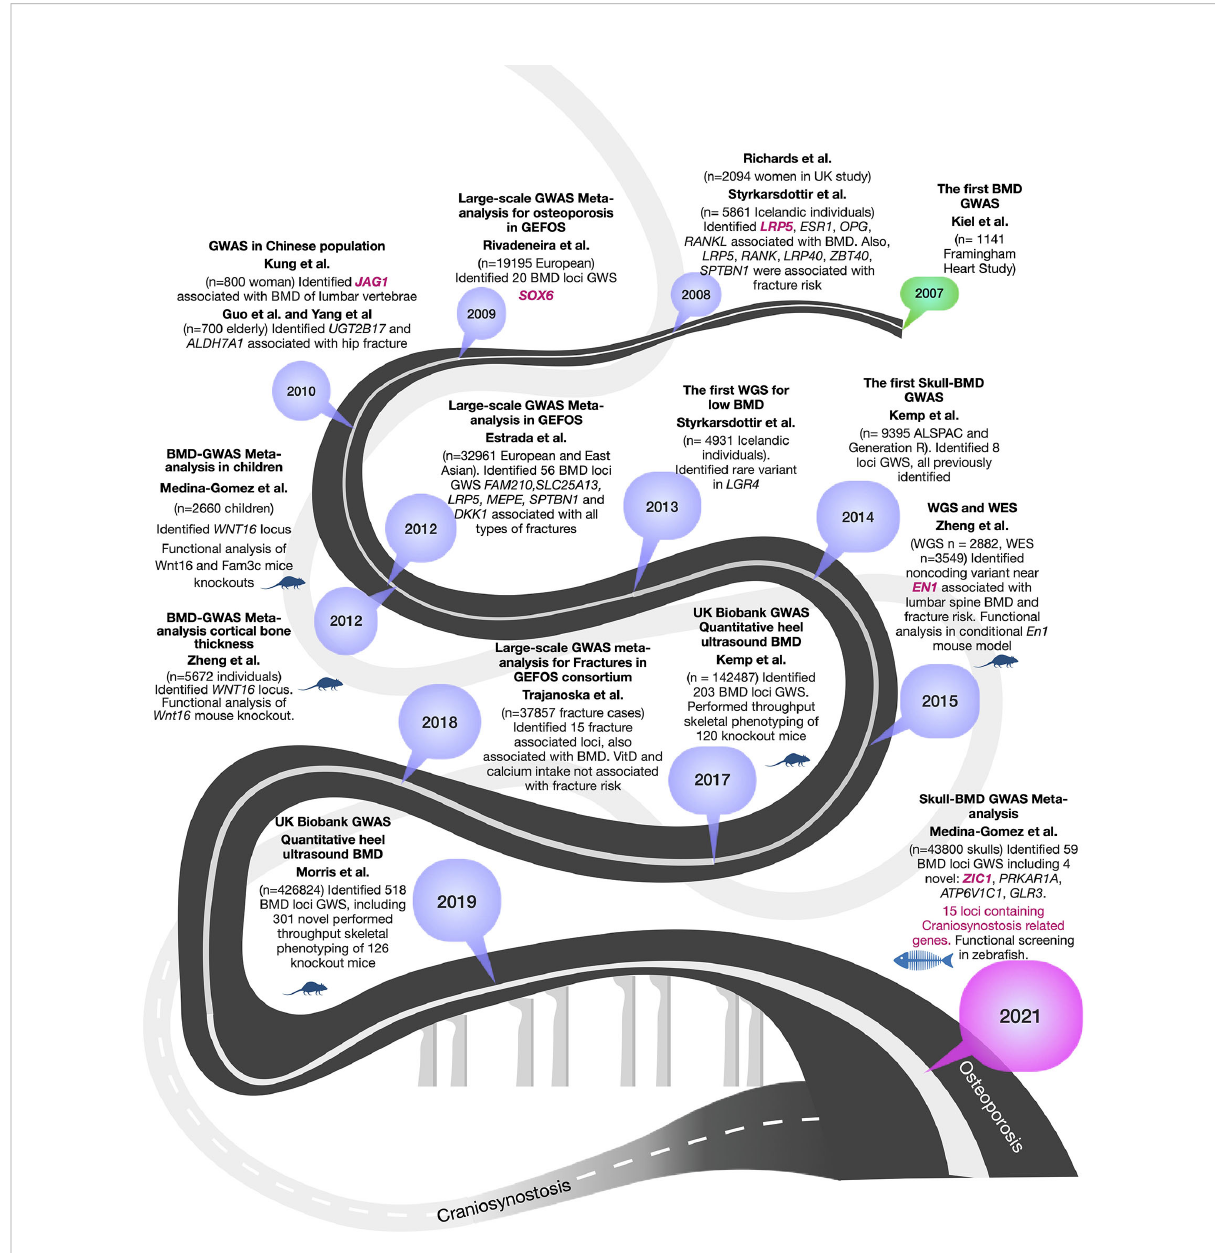
FIGURE 1 Summary of 15 years of GWASs for BMD to the current encounter with craniosynostosis. BMD-GWAS timeline is represented in a dark grey roadmap. Mouse and fi sh symbols indicate studies with functional work performed in mice and zebra fi sh, respectively. Genes highlighted in magenta are known craniosynostosis genes. A light grey roadmap represents the path by the genetics of craniosynostosis that fi nally meets with that of osteoporosis in